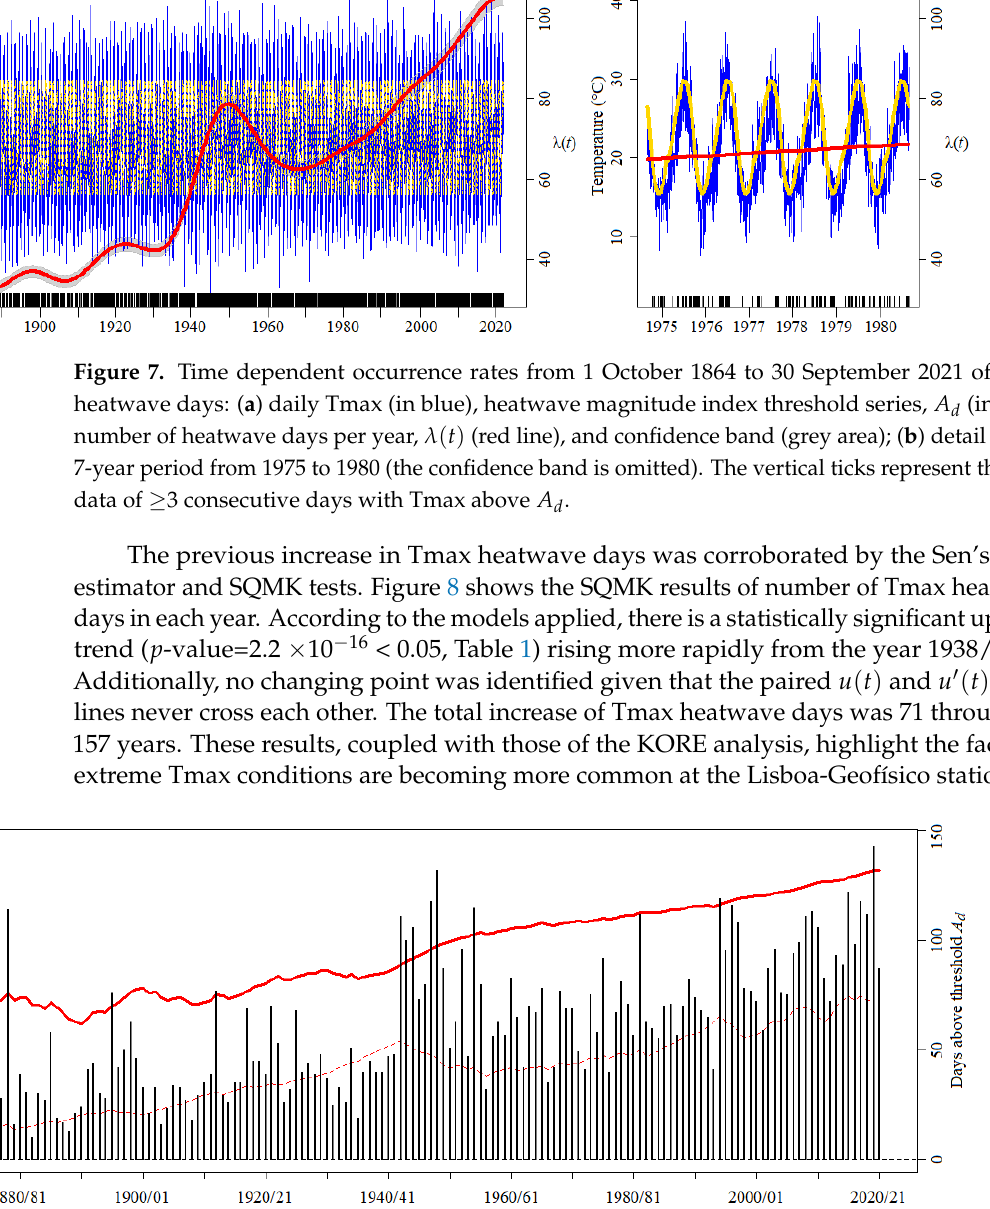
Figure 8. Sequential Mann–Kendall test applied to the annual number of Tmax heatwave days from 1864/65 to 2020/21. The progressive u ( t ) (solid red line) and retrograde u (cid:48) ( t ) (dashed red line) trend series, i.e., the Z-scores, are derived from the number of Tmax heatwave days—daily Tmax above A d —in each hydrological year (black